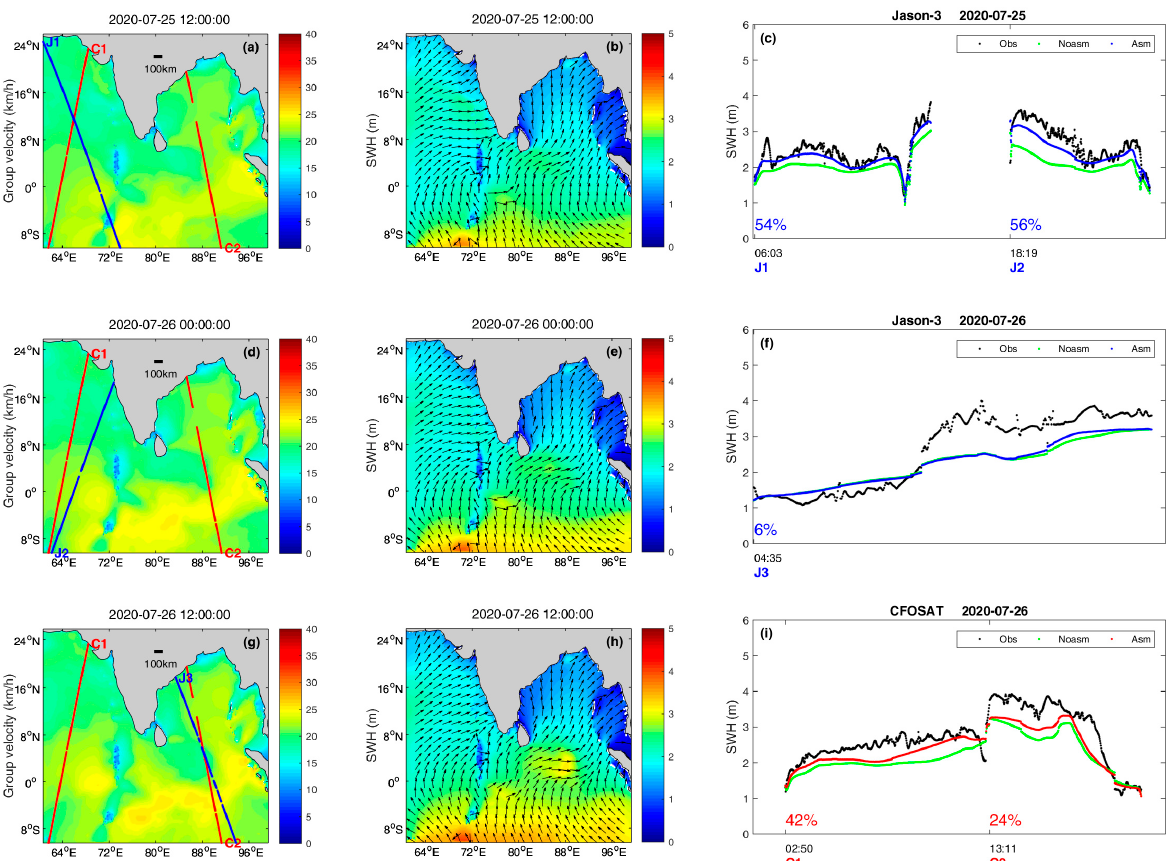
Figure 7. Case B: SWH time series at orbit tracks on 25–26 July 2020. ( a , d , g ): Color represents group velocity in km/h. Blue and red dotted lines indicate orbit tracks of Jason-3 and CFOSAT, respectively. Location of character J1/J2/J3/C1/C2 indicates the start of the orbit track. ( b , e , h ): Color and arrows represent SWH and mean wave direction of model outputs without assimilation. ( c , f ): Black dotted lines indicate Jason-3 measurements; blue and green lines indicate SWH of model outputs with and without assimilation of Jason-3; percentage represents improvement rate of mean absolute error of SWH with assimilation compared to without assimilation. ( i ) Black dotted lines indicate CFOSAT measurements; red lines and green lines indicate SWH of model outputs with and without assimilation of Jason-3; percentage represents improvement rate of mean absolute error of SWH with assimilation compared to without